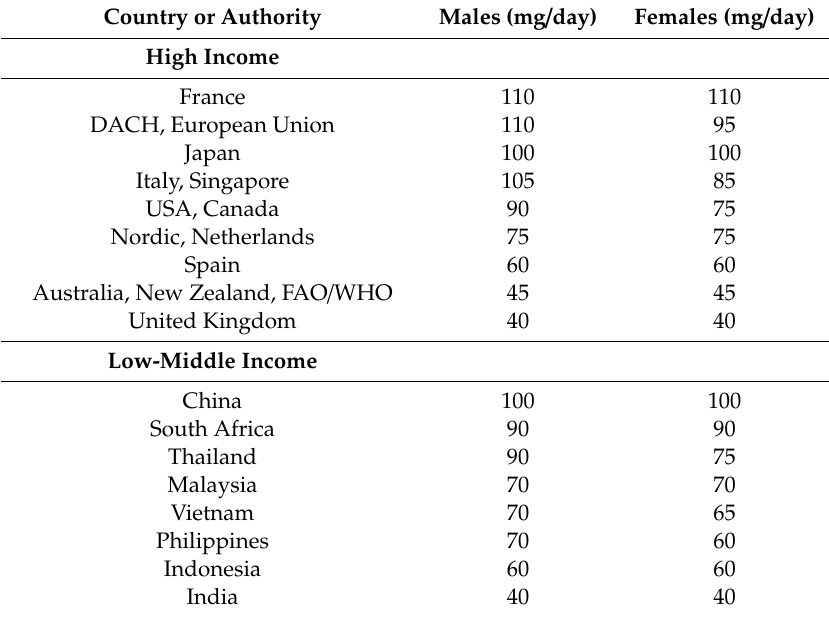
Table 4. Global recommended dietary intakes for vitamin C. Country or